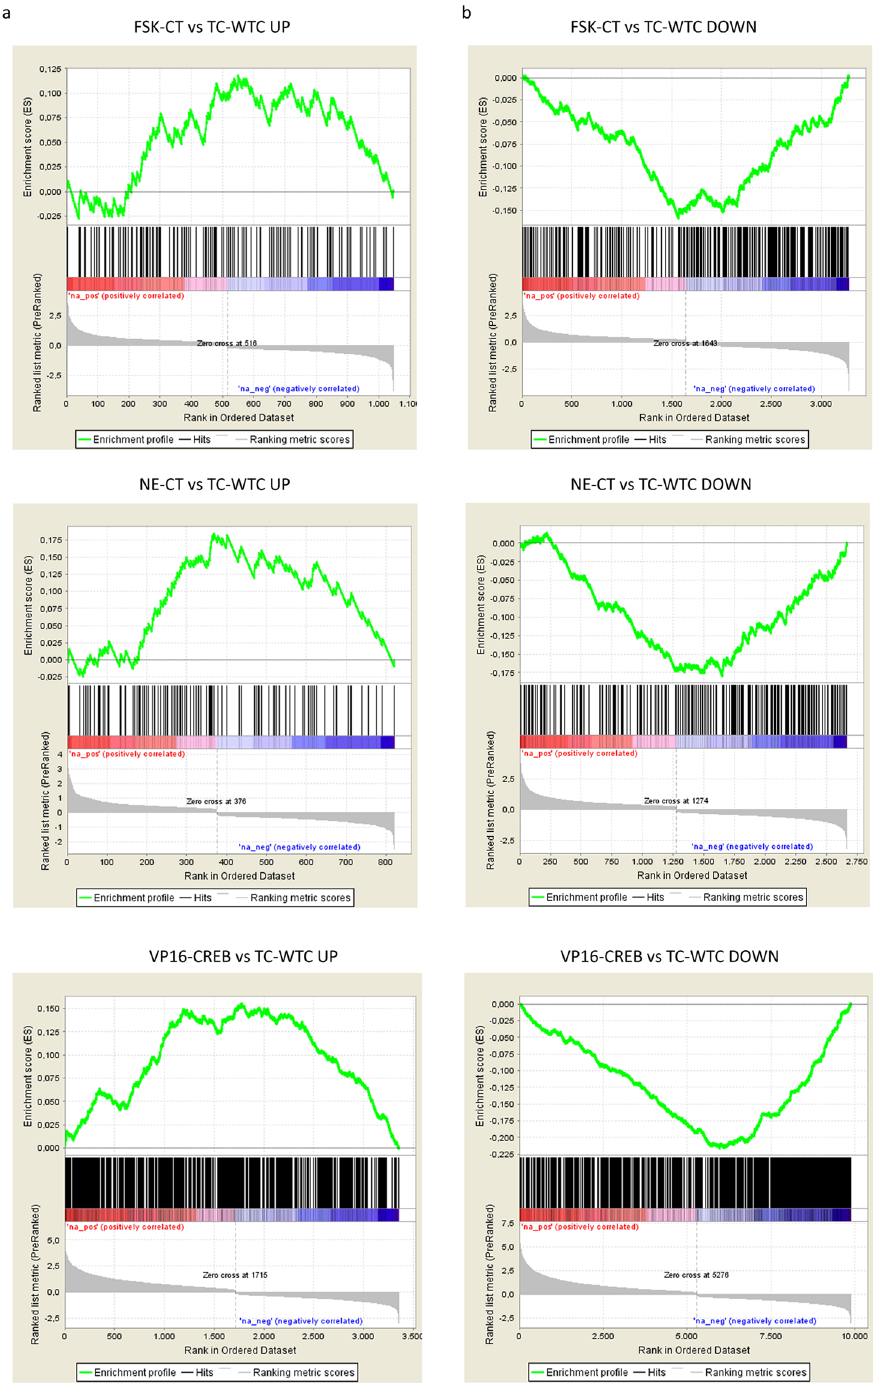
Figure 3. GSEA-based comparison of ast-CREB-dependent transcription in vitro and in vivo . Enrichment of DEG-Q1-TRAP databases in transcriptomes from mouse cortices with targeted expression of VP16-CREB in astrocytes (Gfa2-TtA/TetO-VP16-CREB mice). Transgen expression in mice was triggered by brain injury. GSEA comparisons were carried out between in vitro databases and the up-regulated ( a ) and down-regulated ( b ) fraction of transgenic vs wild-type mice (TC-WTC). The upper parts of the plots show enrichment scores, black lines represent the genes present in both lists (hits) and the bottom parts show the data sets ranked by gene expression